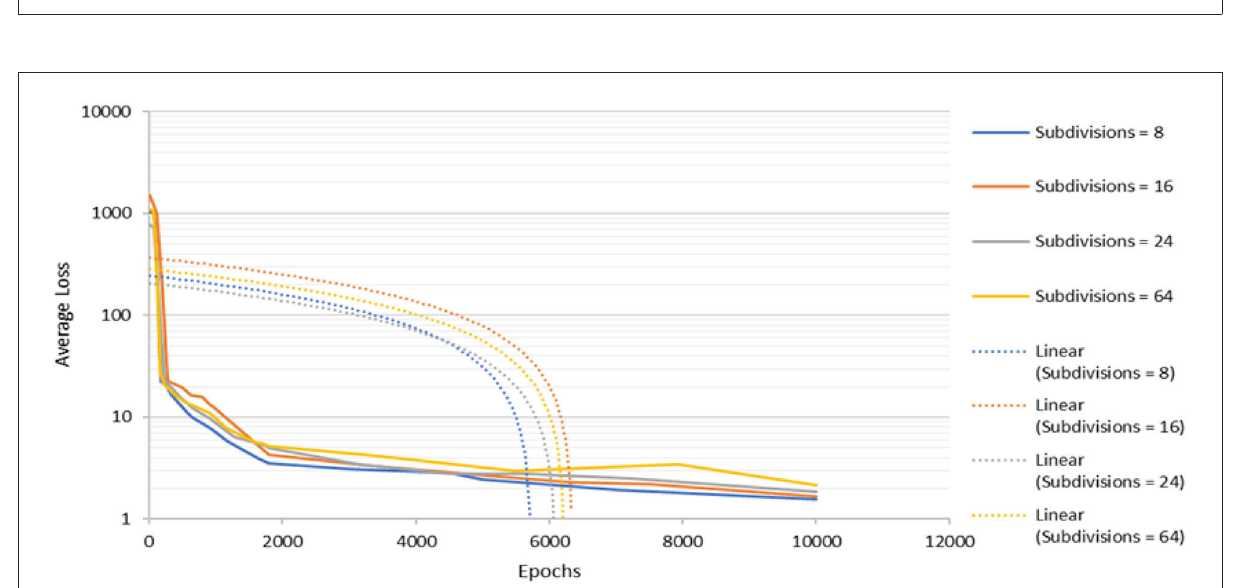
FIGURE4 The detection model’s convergence rate during the training process.